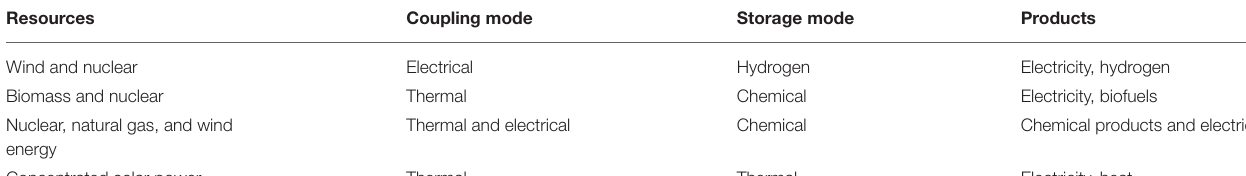
TABLE 3 | Examples of Renewable energy sources and nuclear in hybrid energy systems (Ruth et al., 2014).